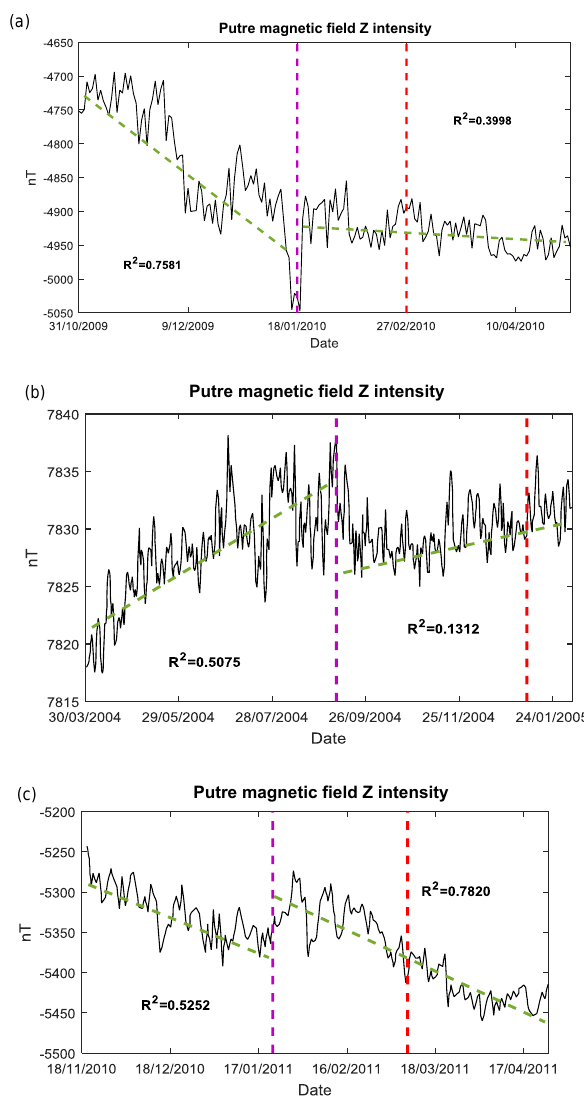
Figure 4. (a) Behavior of B in Maule region, Chile, before and after 27 February 2010 seismic event (includes what precedes the jump, represented by the change in R -squared value) of 18 January